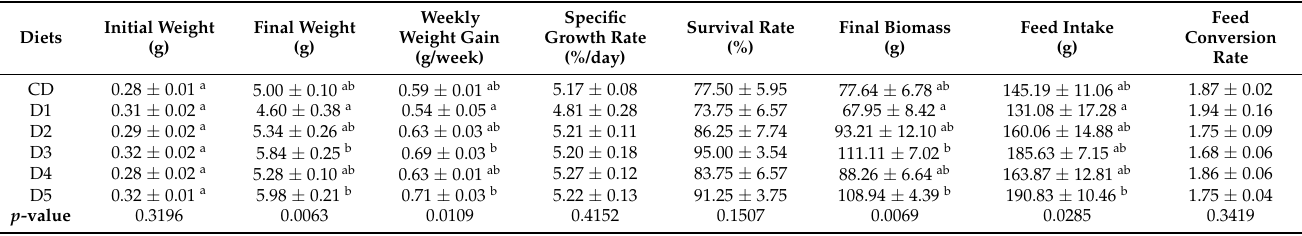
Table 3. Effect of experimental diets on growth performance of Litopenaeus vannamei .